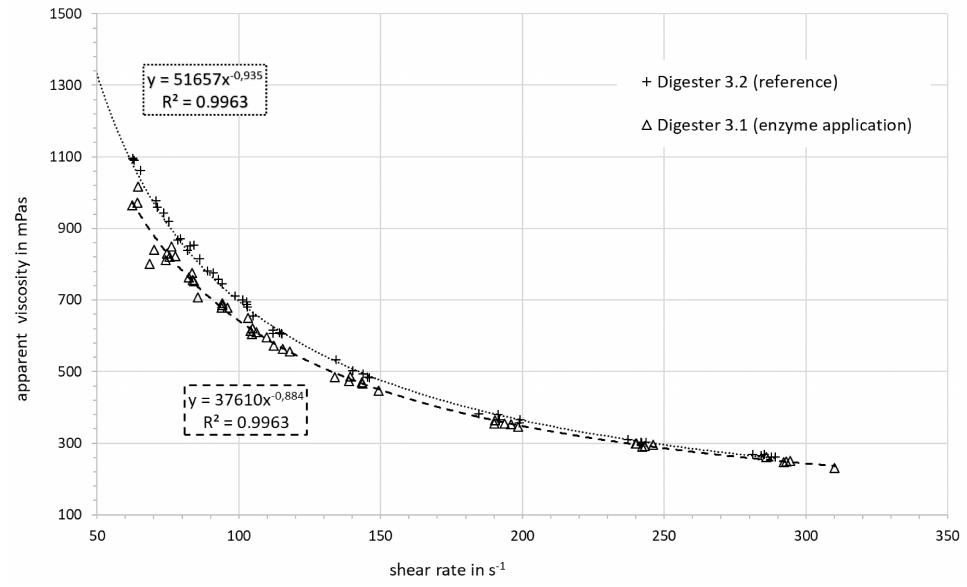
Figure 7. Apparent viscosity vs. the shear rate: comparison of digester slurry with and without enzyme